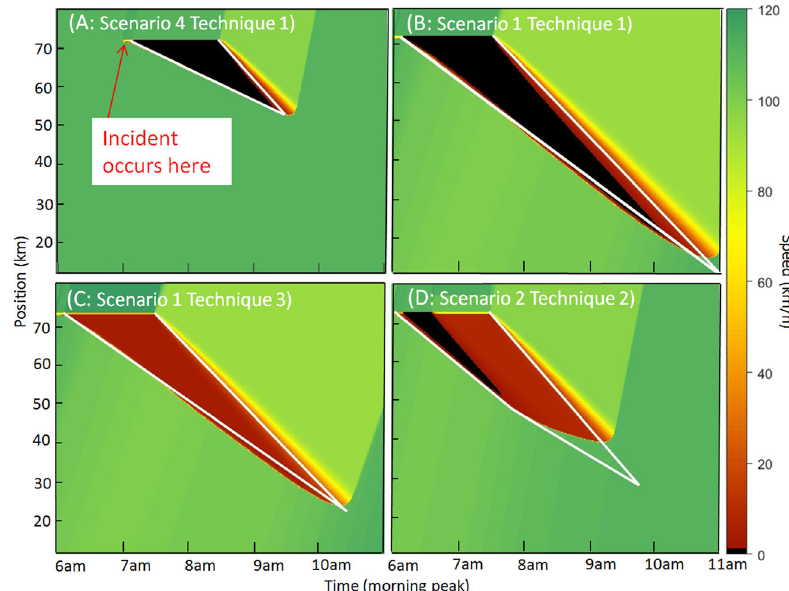
Fig. 8 Comparing traffic state estimations using CTM-v simula- tion and macroscopic queue modelling for several cases with